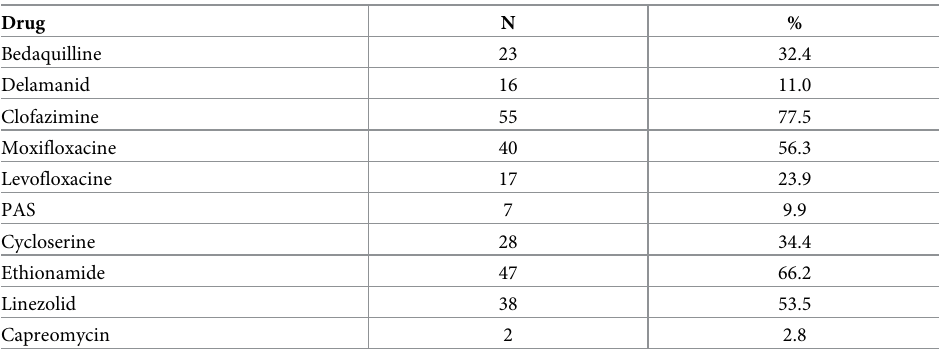
Table 4. Drugs included in individualized regimens.